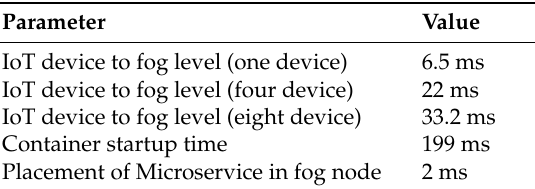
Table 5. Simulation Parameters.